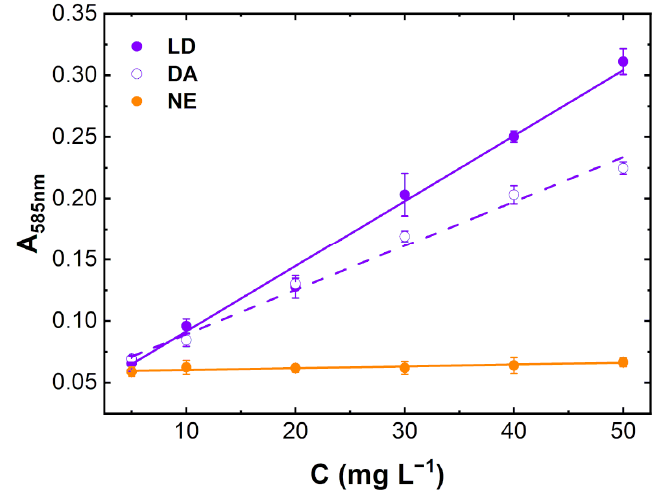
Figure 2. Catecholamines calibration curves in human urine spiked with levodopa (LD, purple circles), dopamine (DA, white circles), and norepinephrine (NE, orange circles), from 5.0 to 50.0 mg L − 1 , and dilute 1:8 ( v / v ) with a proper bu ff er (150 mM Mg(Ac) 2 , 150 mM NH 4 Cl at pH 9.4 in